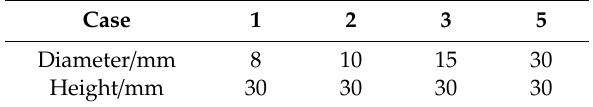
Table 2. The designed parameters of the diameter of different starter blocks.